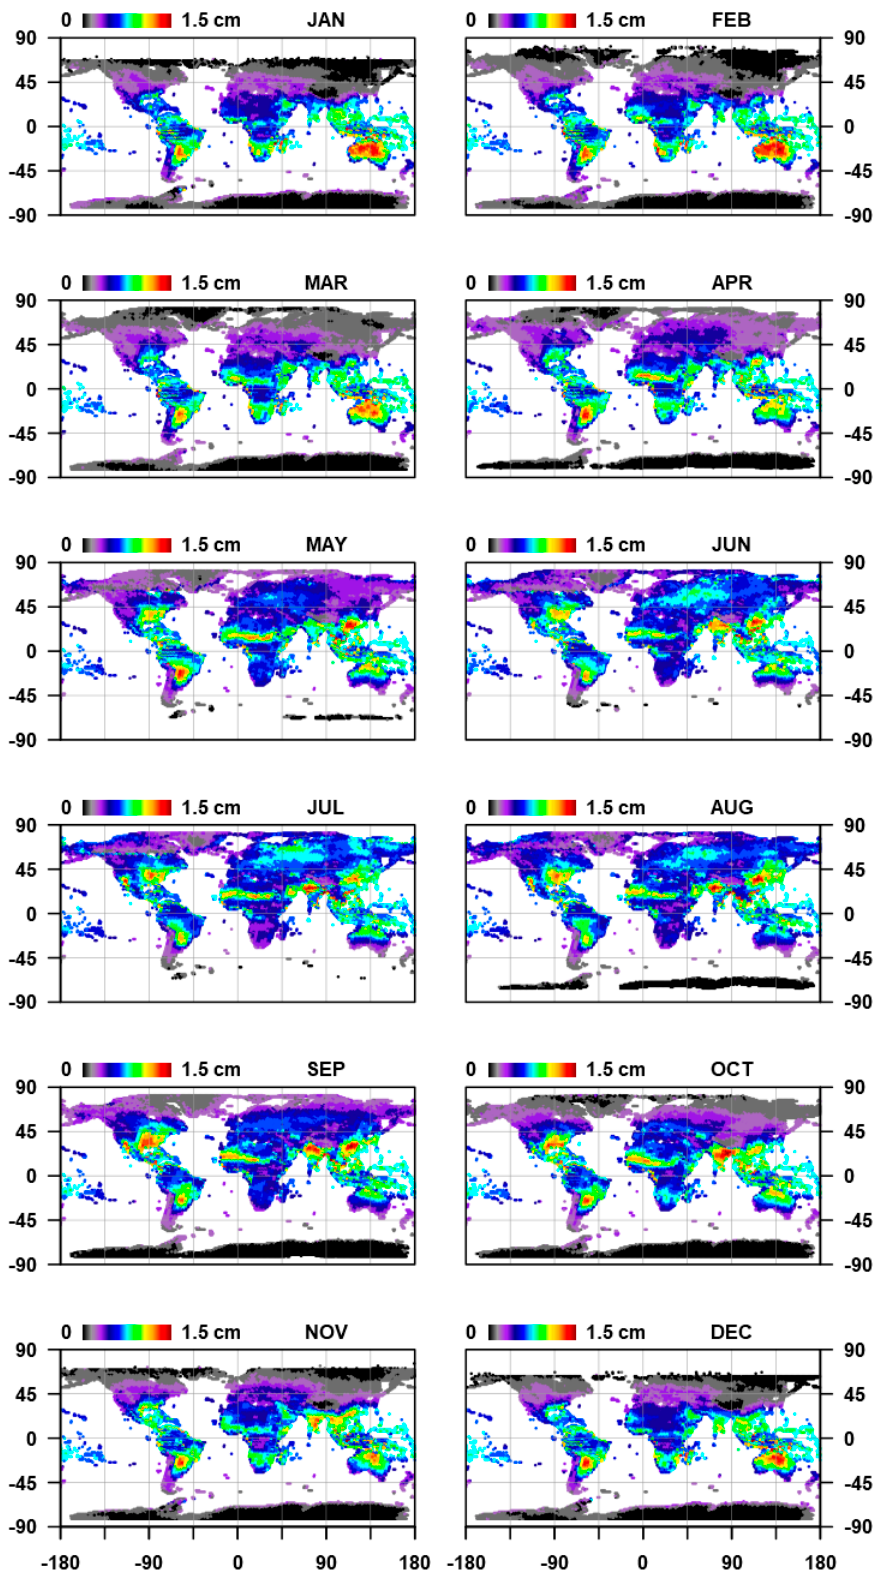
Figure 3. Long-term variability of water vapor per month, standard deviation from February 2000–July 2018 based on daily values.